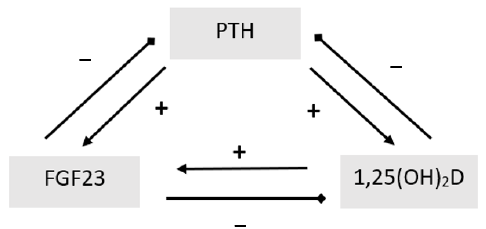
Figure 2. PTH/FGF23/1,25(OH) 2 D interaction.